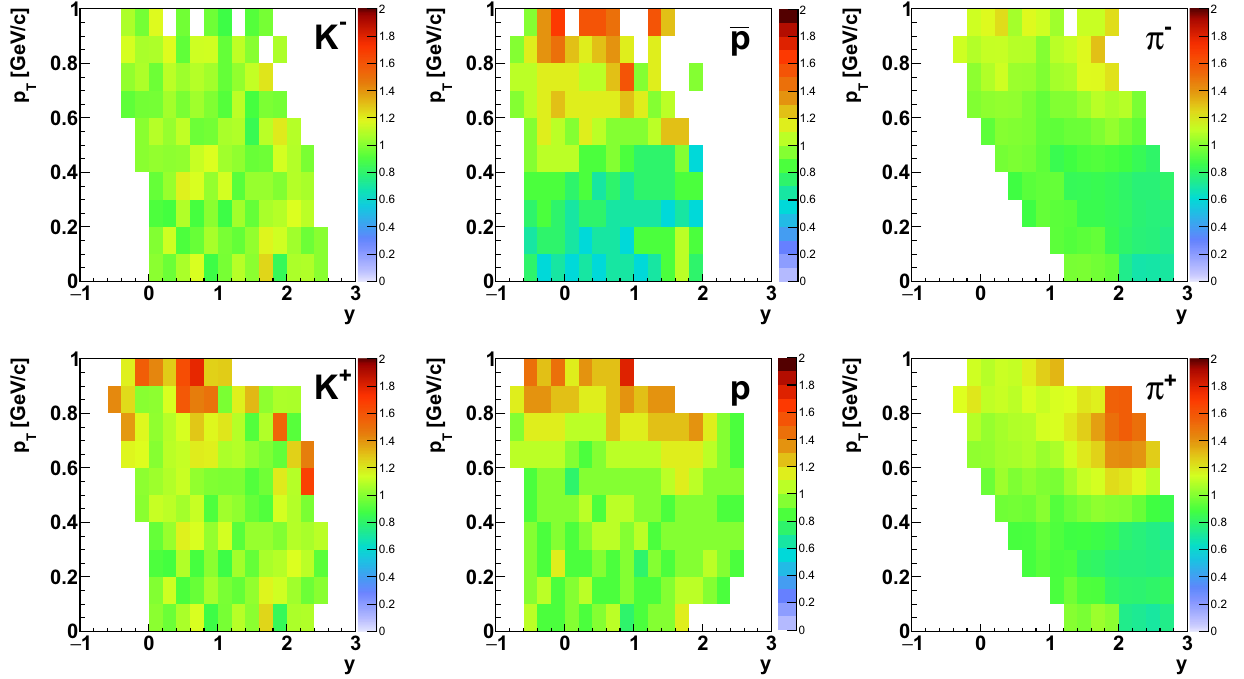
Fig. 40 Two dimensional distributions d 2 n /( dp T dy ) of π − , π + , K − , K + , p and ¯ p produced in inelastic p + p interactions at 158 GeV / c divided by the EPOS model [21]